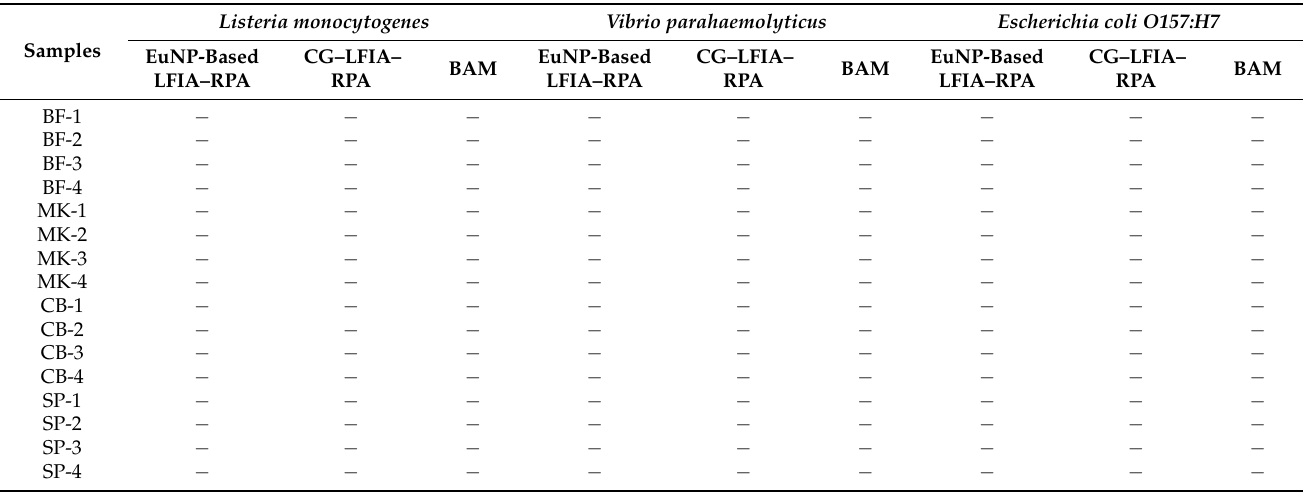
Table 4. Determination results for Listeria monocytogenes , Vibrio parahaemolyticus , and Escherichia coli O157:H7 in field food samples. Listeria Samples